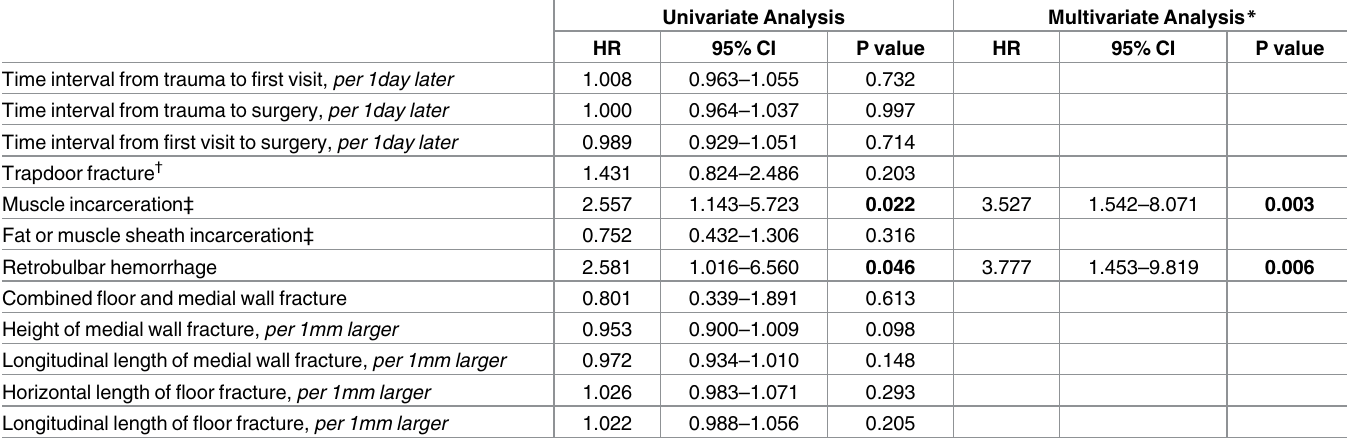
Table 5. Factors associated with resolution of ocular motility